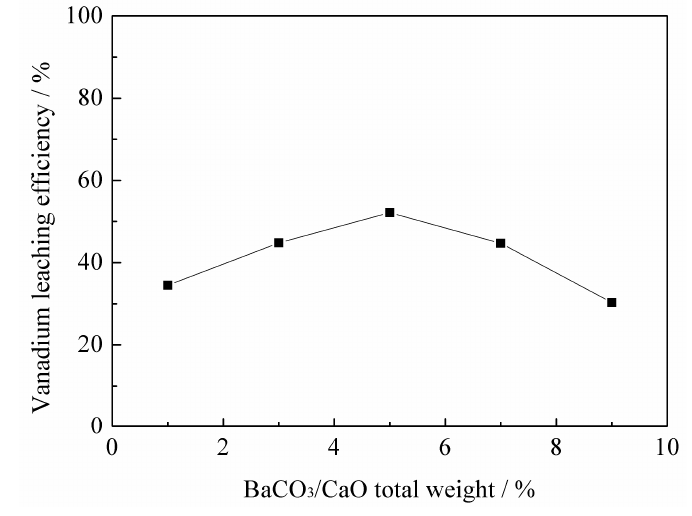
Figure 3. Effect of BaCO 3 /CaO total weight on vanadium leaching efficiency.